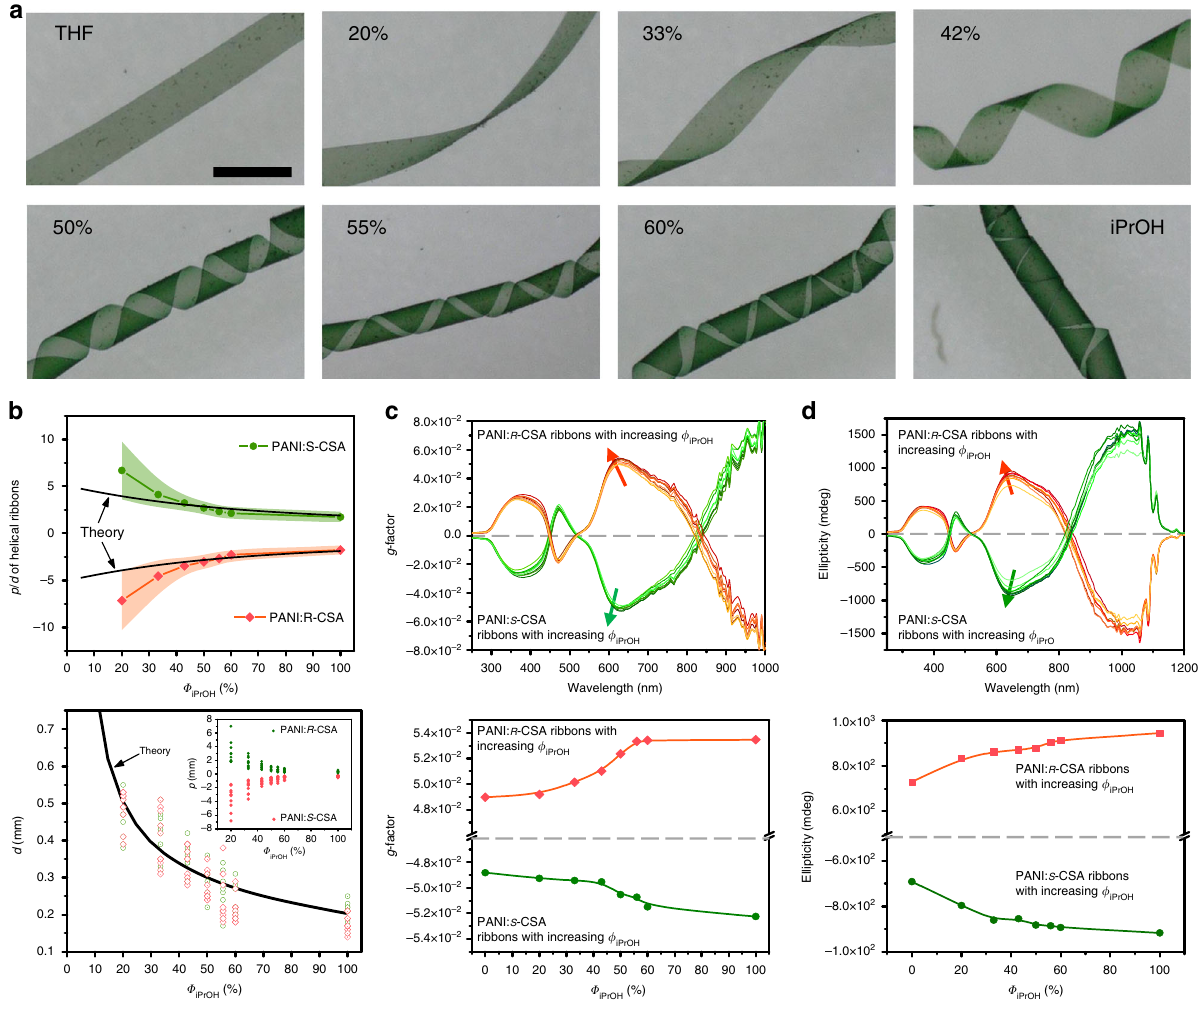
Fig. 3 Macroscopic helical chirality generation in the stripe. a Photographs of the left-handed helical ribbons with different feature size of helicity under different Φ iPrOH . By introducing iPrOH into THF, the PANI: s -CSA macro stripe shrunk into left-handed helical ribbon step-by-step. Scale bar corresponds 0.5 mm. b Feature size of helicity p (helical pitch), d (diameter of the cylindrical helix), and proportional relation p/d of the helical ribbons decreased with increasing Φ iPrOH . The black lines are theoretical calculating values of the feature size of helicity. c g -factor, and d the corresponding CD of the PANI: ѕ -CSA and PANI: ʀ -CSA ribbons measured in the co-solvent with different Φ